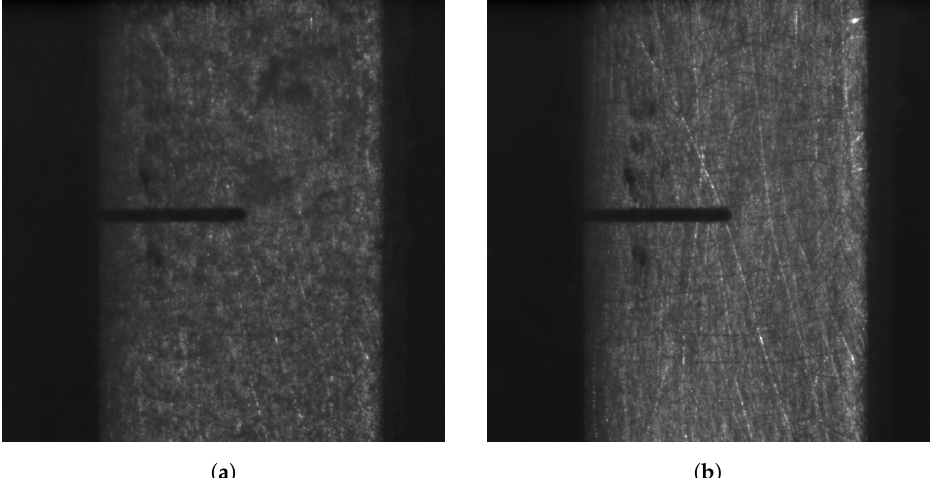
Figure 3. Comparison of surface images for DIC before and after the digital removal of bubbles during monotonic loading. ( a ) Image showing specimen surface with the gas bubbles moving along it. ( b ) Image showing specimen surface after digitally removing the bubbles. The dark features around the notch flanks are material defects.